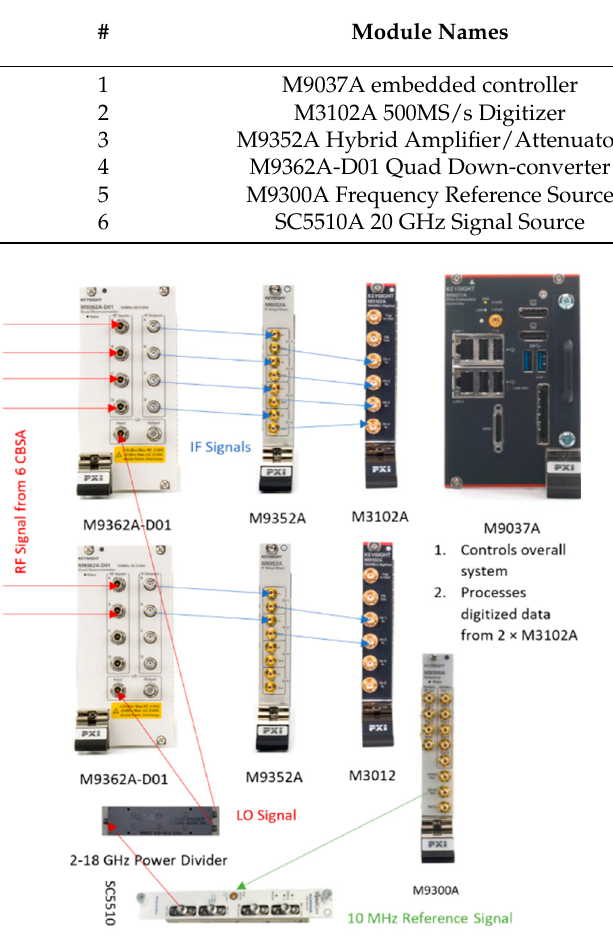
Figure 4. Signal paths in the PXIe receiving system in Figure 3.